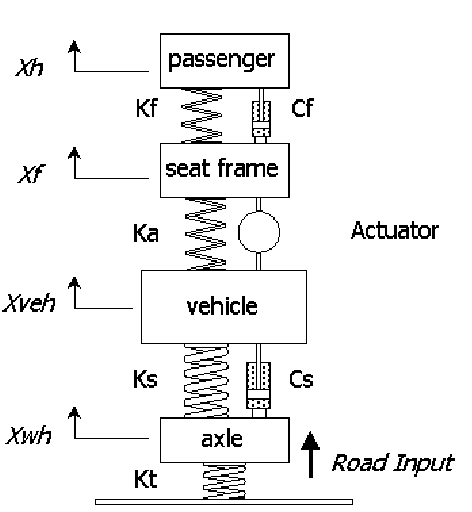
Fig. 2. Tolerance to vertical vibration [7].